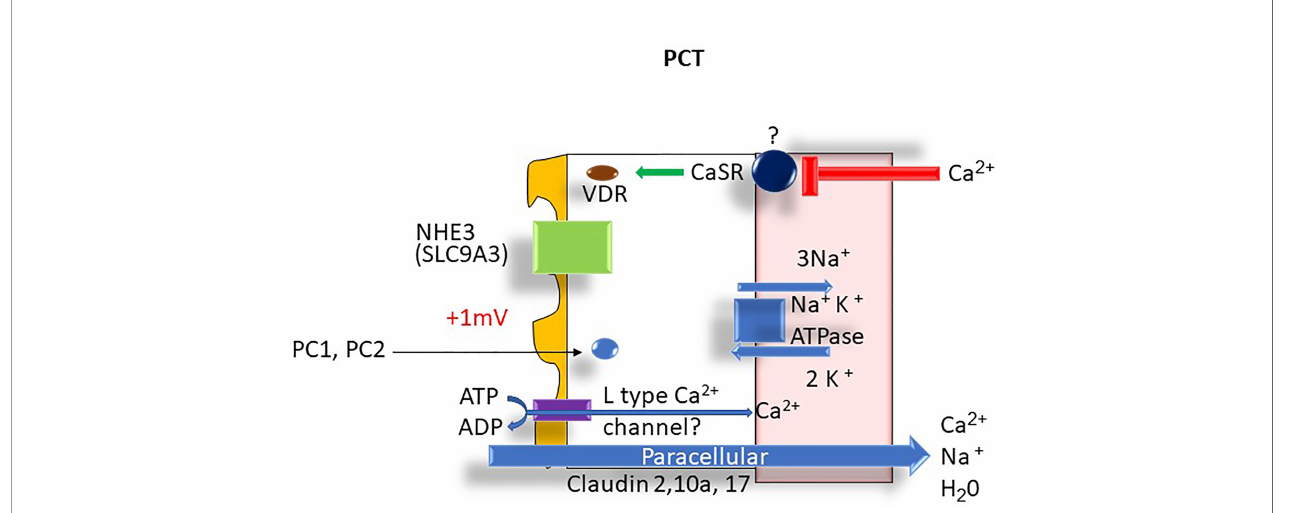
FIGURE 4 | Proximal tubule Ca 2+ transport: ATPase, adenosine triphosphatase; Ca 2+ , calcium; Cl - , chloride; H 2 O, water; K + , potassium; mV, millivolt; Na + , sodium; NHE3, Na + -H + exchanger 3; PCT, proximal convoluted tubule; PC1, polycystin 1, PC2, polycystin 2; VDR, vitamin D